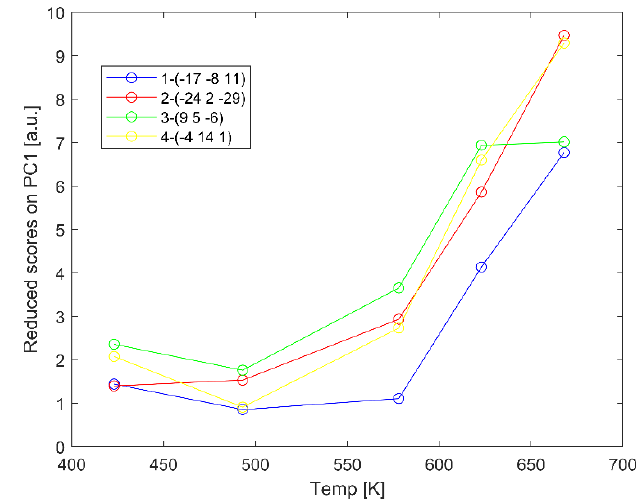
Figure 4. Plot of reduced scores in the PC1 direction as calculated for four polycrystalline rhodium crystallites under different temperatures at 75 min of the oxidation exposure.